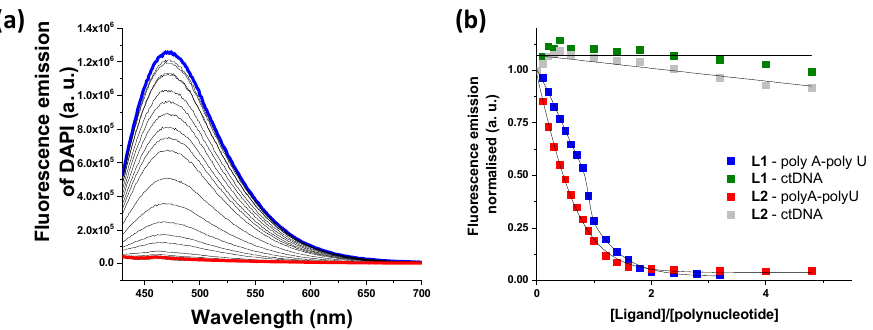
Figure 5. ( a ) Changes in fluorescent emission obtained from DAPI displacement assays with poly A-poly U and L1 (blue line, initial spectrum and red line, final spectrum). ( b ) Plot of the fluorescence emission vs. ratio in the DAPI displacement